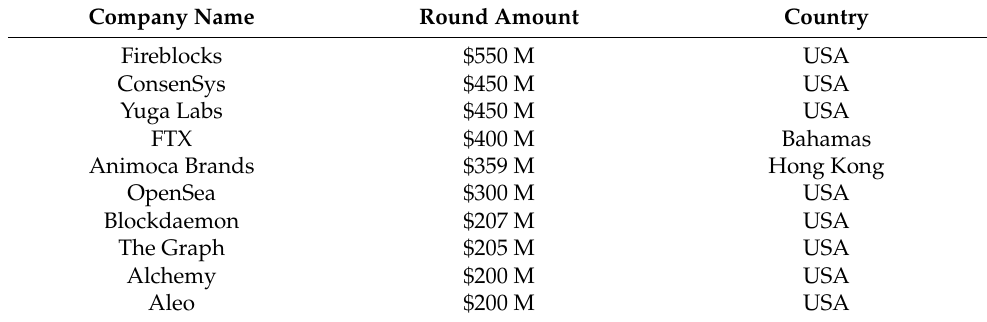
Table 8. Global top equity deals in Q1 (cid:48)